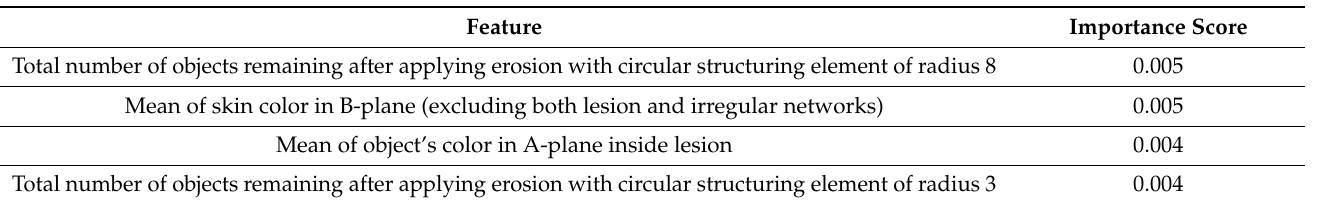
Table A2. Cont. Feature Importance